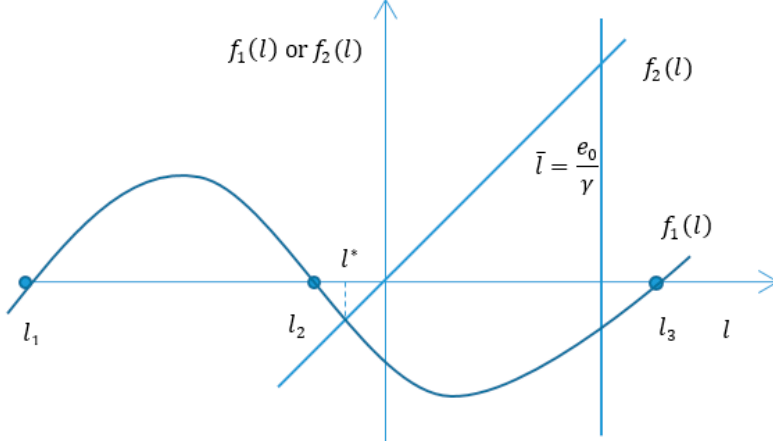
Figure A2. The curve of the function (cid:1858) (cid:2869) ((cid:1864)) or (cid:1858) (cid:2870) ((cid:1864)) in Sub-case B.1.